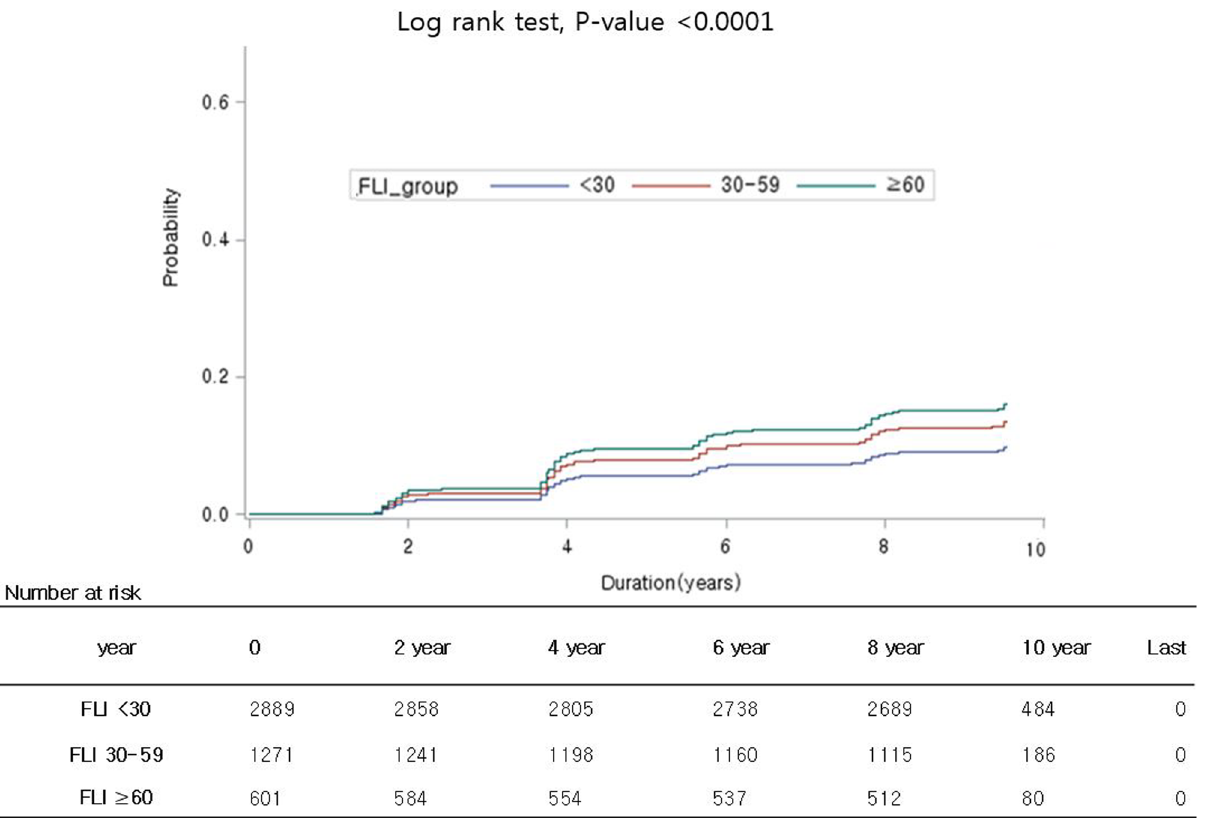
Fig 2. Kaplan-Meier curves of incident CKD according to FLI categories. CKD, chronickidney disease;FLI, fatty liver index.